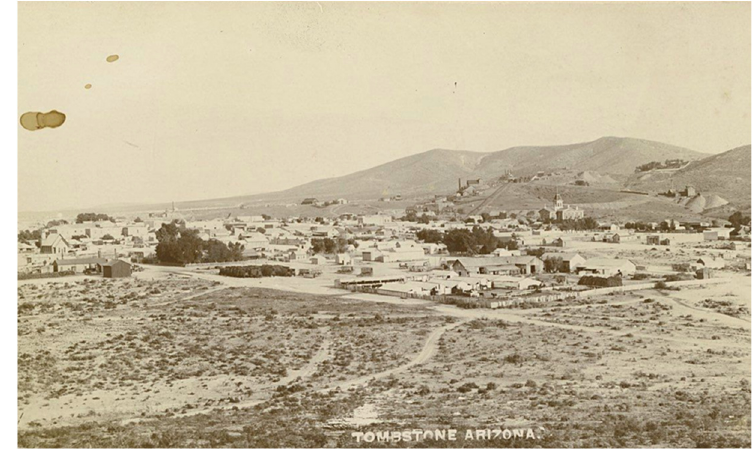
Figure 17. Tombstone, Arizona, 1880 (photographer unknown).